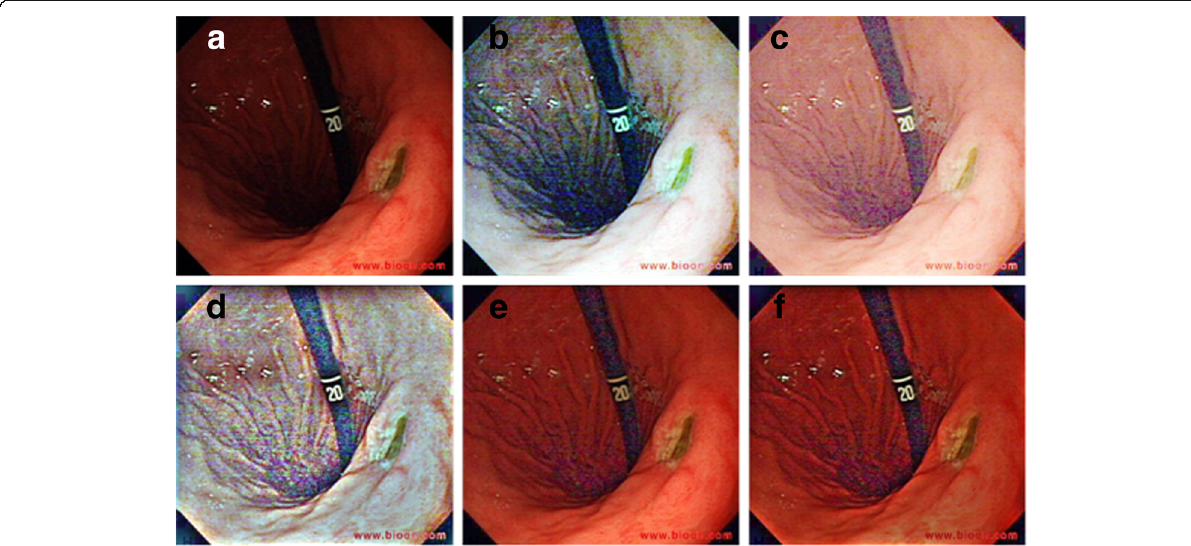
Fig. 7 Enhanced results using different methods. a Original image. b LHE. c MSR. d SARV. e NPEA. f AD- L 1 L 2